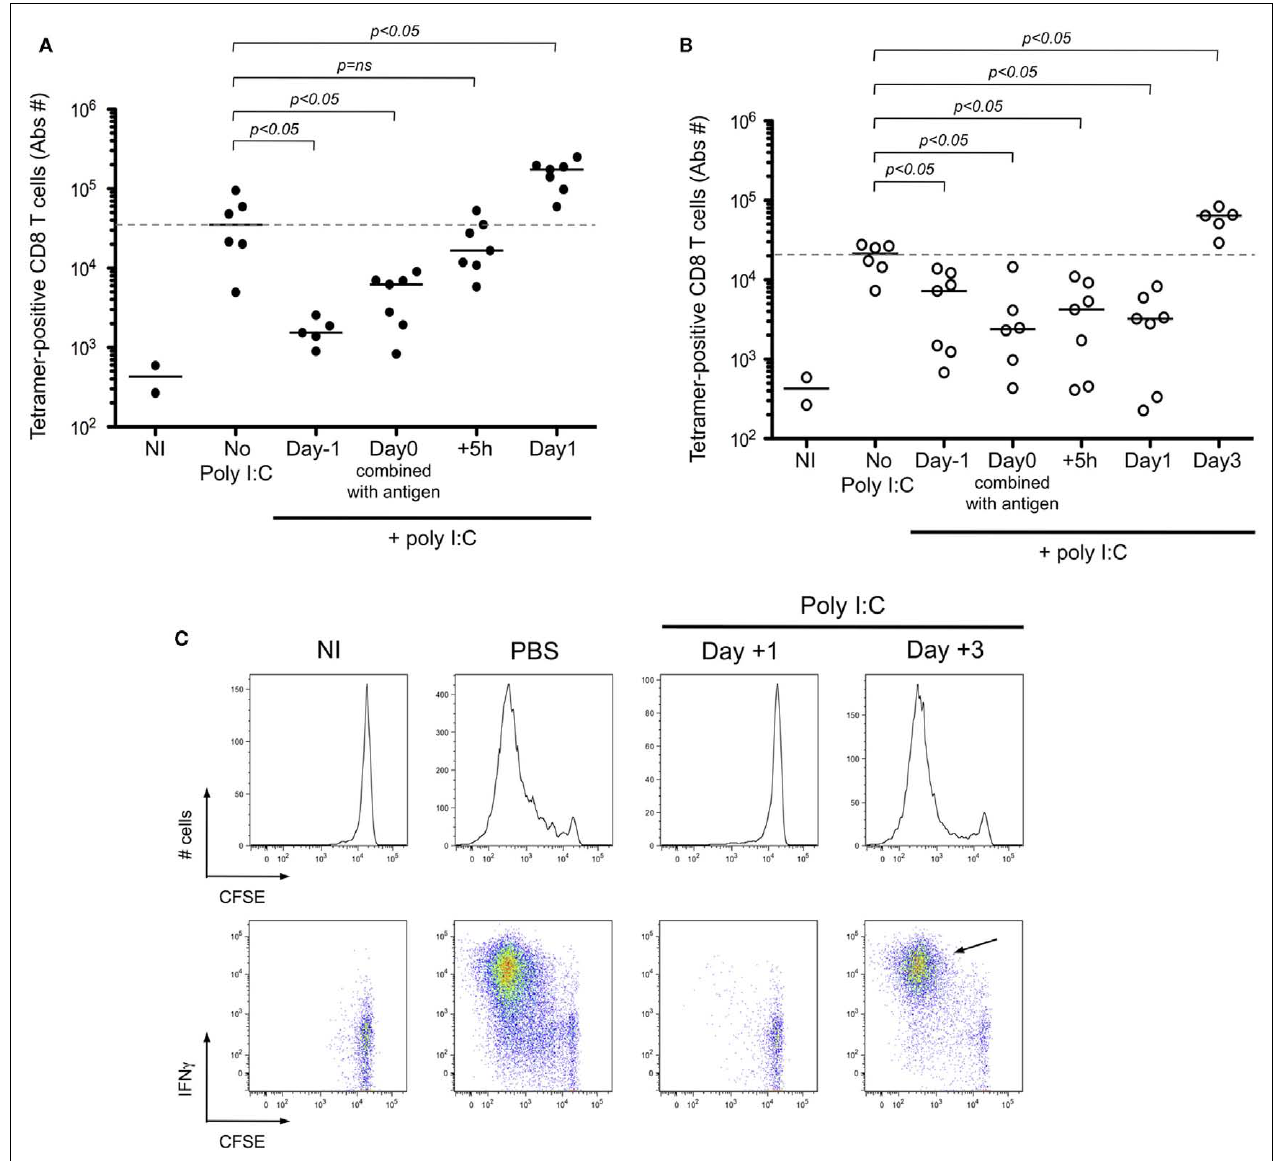
FIGURE 7 |Adjuvant delivery must occur after antigen capture in order to achieve CD8 + T cell priming. (A,B) Mice were immunized